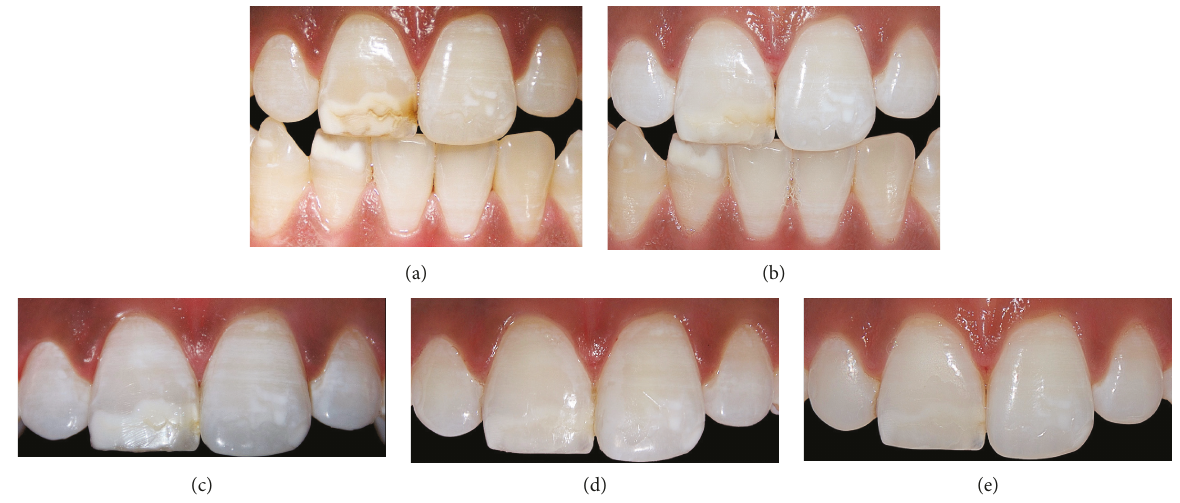
Figure 3: Brownish lesion related to molar incisor hypomineralization (a). After one week of at-home whitening using 10% carbamide peroxide gel (b), the stain was partially removed and has disappeared completely by the end of the bleaching treatment (c). Immediate result after performing resin in fi ltration (d). 3 months after treatment (e). Signi fi cant improvement in the aesthetic appearance of this patient ’ s teeth was achieved, and the case was thus considered to be a